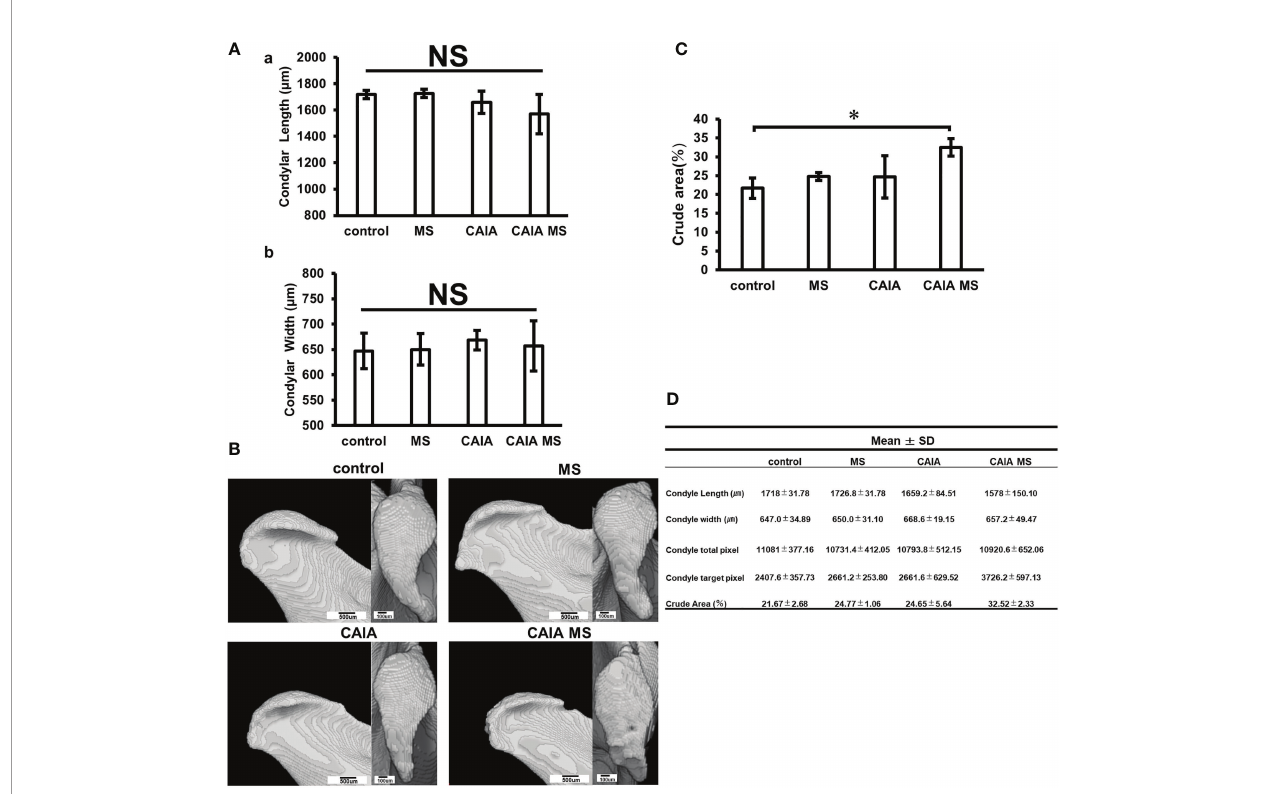
FIGURE 3 | Evaluation of mandibular condyle morphology in micro-CT. (A) (a) Mandibular condyle length of each group; (b) Mandibular condyle width of each group. There was no signi fi cant difference in change in either. (B) Mandibular condyle lateral (scale bar: 500 m m) and superior (scale bar: 100 m m) morphology of each group. The arrow indicates crude area. (C) Percentage of crude area mandibular condyle in each group. The crude area was larger in the CAIA MS group. *p < 0.05. (D) Details about mandibular width and length diameters, whole and target pixels, and crude area are shown. NS, not signi fi